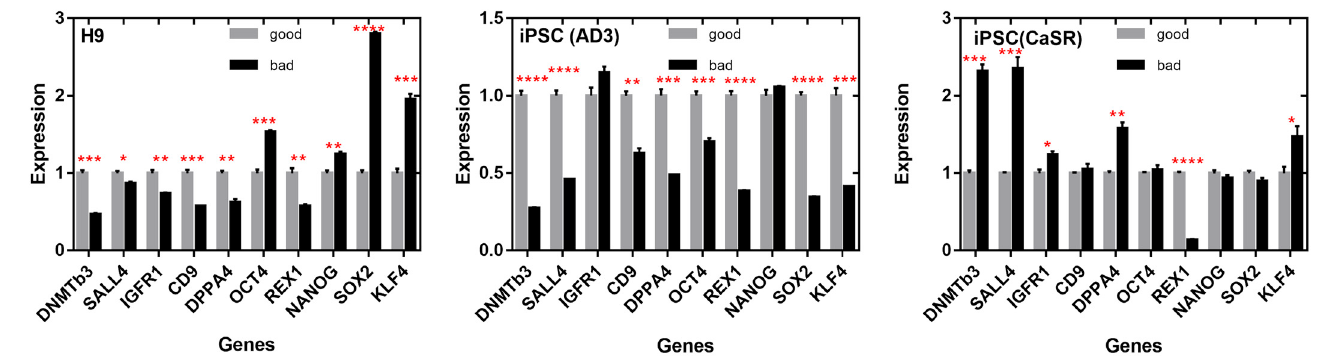
Figure 10. Relative expression of ten pluripotent genes in “bad” (black) and “good” (grey) colonies, according to morphological phenotype, measured for each cell line using qRT-PCR. Data are presented as means ± SEMs. Values were normalized to the mean expression in good colonies separately for each line. * p < 0.05; ** p < 0.01; *** p < 0.001; **** p < 0.0001.